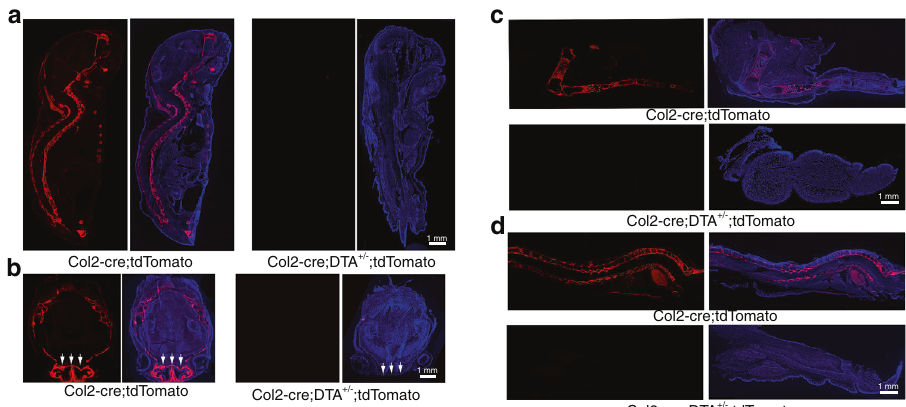
Fig. 1 Spatial expression of Col2 + lineage progenitors in newborns and removal of the majority of Col2 + cells by DTA. a Fluorescence images showing the pattern of Col2 + lineage progenitors in middle sections of Col2-cre;tdTomato and Col2-cre;DTA + / − ;tdTomato newborn mice. b Fluorescence images showing the pattern of Col2 + lineage progenitors in transected skulls of Col2-cre;tdTomato and Col2-cre;DTA + / − ; tdTomato mice. White arrow, defective nasal capsule in a Col2-cre;DTA + / − ;tdTomato mouse. c Fluorescence images showing the pattern of Col2 + lineage progenitors in the lower extremities of Col2-cre;tdTomato and Col2-cre;DTA + / − ;tdTomato newborn mice. Note the complete loss of tdTomato + cells in the long bones of Col2-cre;DTA + / − ;tdTomato mice compared with wild-type newborn mice. d Fluorescence images showing the pattern of Col2 + lineage progenitors in middle sagittal sections of spines of Col2-cre;tdTomato and Col2-cre;DTA + / − ;tdTomato newborn mice. n = 6 mice per condition; three independent tracing mouse models with tdTomato transgenic lines, we determined the function of Col2 + cells in the embryonic and postnatal stages. Our fi ndings provide the fi rst demonstration that Col2 + cells contribute to calvarial bone development, that intramembranous ossi fi cation derived from Col2-negative pro- genitors is involved in long bone and rib development but does not participate in spine development, and that Col2 + cells also contribute to blood vessel formation during skeletal develop- ment and fracture healing.